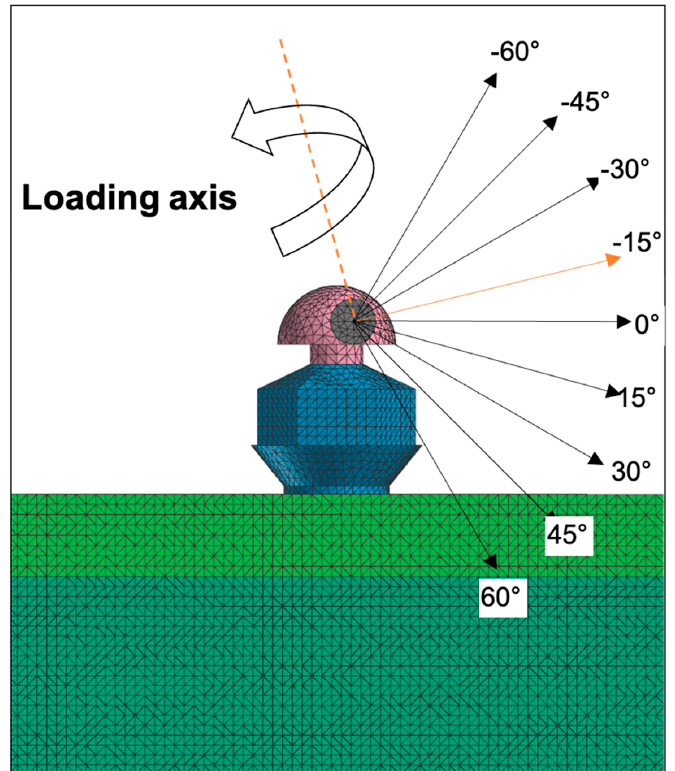
Figure 3. Miniscrews were assumed to be placed with various angulations on the alveolar bone surface. An archwire parallel to the alveolar bone and the occlusal plane passing through the hole of the angulated miniscrew forms corresponding angles with the long axis of the miniscrew. To make the same condition among the models, whole screw part was placed into the alveolar bone and the archwire was inserted with angles from − 60 ◦ to +60 ◦ with an angle interval of 15 ◦